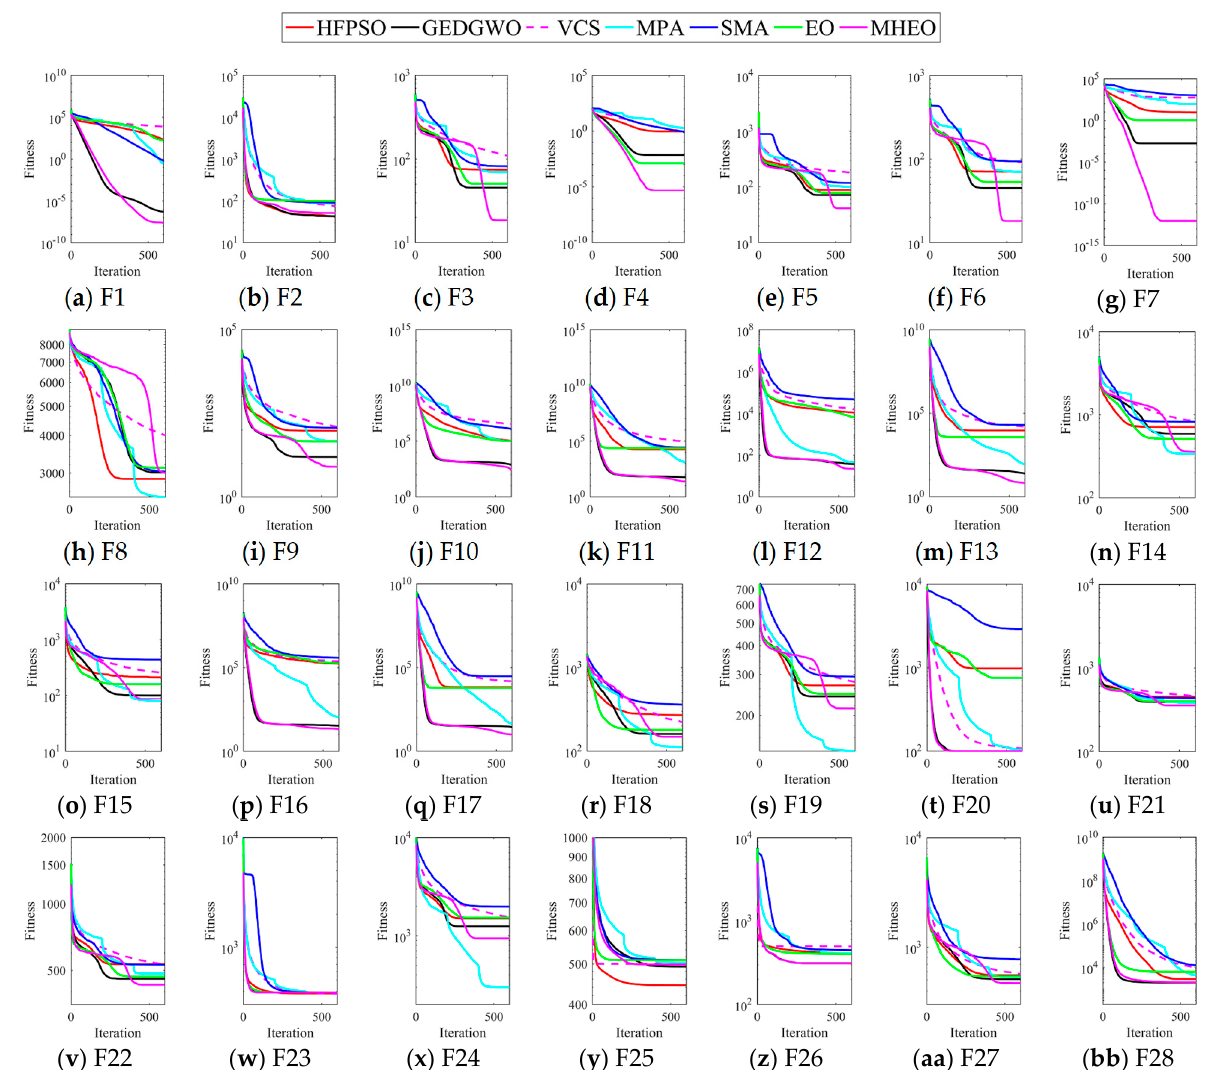
Figure 2. Boxes diagram of CEC2017. Subfigures a-bb represent functions F1–F28 respectively . Convergence speed and convergence accuracy are also important indicators of algorithm performance, and Figure 3 shows the mean error convergence curve graphs for the seven algorithms solving the CEC2017 test suite. MHEO has a faster convergence speed and better convergence accuracy in 11 tested functions (F1, F4, F7, F10–F13, F16–F17, F20, F26). For F3, F5, F6, F9, F21–F22 and F27, MHEO converges slowly at the beginning, but converges faster and has better convergence accuracy in the later stages compared to other algorithms.